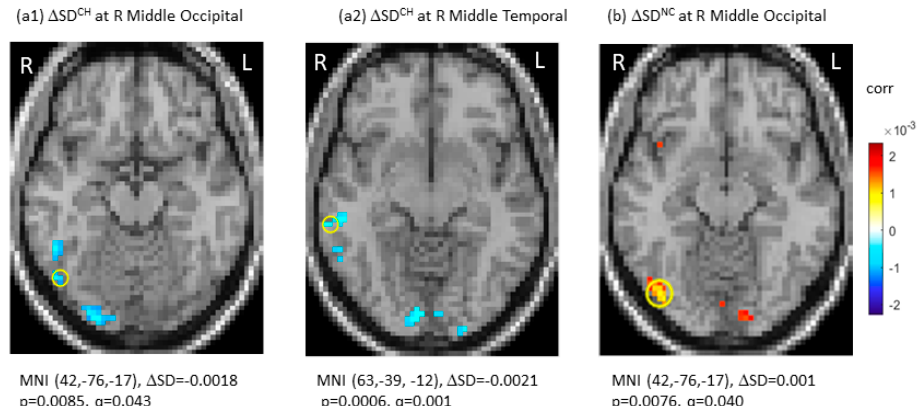
Figure 1. Significant longitudinal changes in blood-oxygen-level-dependent (BOLD) signal variability in standard deviation ( ∆ SD BOLD ) in the chemotherapy group (CH) ( a1 , a2 ) and in the no-chemotherapy group (NC) ( b ). The significant regions were indicated with Montreal Neurological Institute (MNI) coordinates and marked by “o”. CH: chemotherapy group; FDR: false discovery rate; L: left side; NC: No-chemotherapy group; q = p FDR after multiple comparison, R: right side, ∆ : longitudinal change.